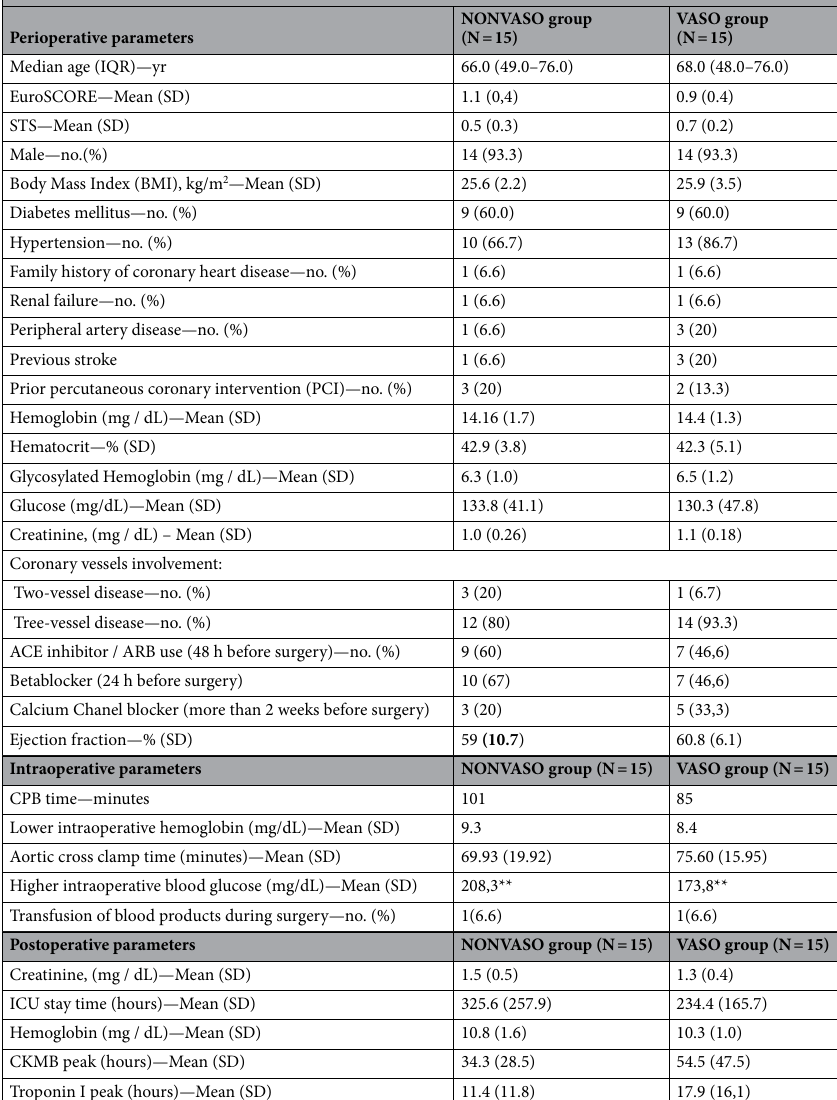
Table 1. A cohort of 30 samples was divided into patients who developed (VASO group, N = 15) and did not (NONVASO group, N = 15) VS after surgery. The groups were compared concerning peri, intra and postoperative variables. Data are presented as number of patients and percentage in brackets for dichotomous variable or median and inter-quartile-range (IQR) or standard deviation (S.D). The symbols *** represent ( P <